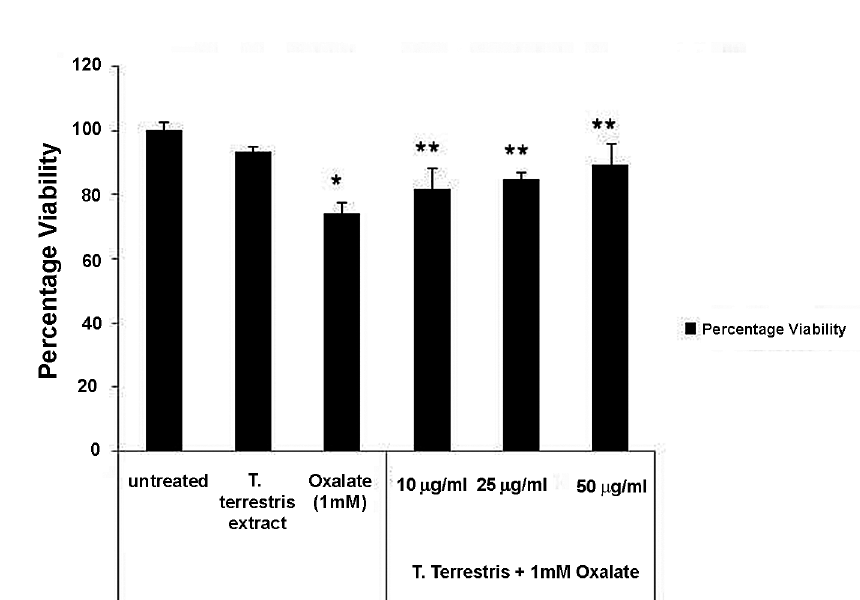
Figure 3 – Effect of Tribulus terrestris on the viability of NRK 52E. Data are mean ± SEM of three independent observations. * p < 0.05 versus untreated control, ** p < 0.05 versus oxalate control.